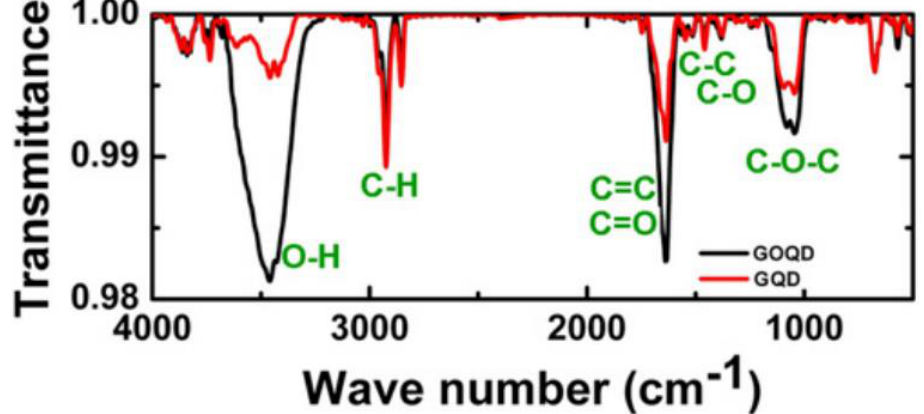
Figure 15. FT-IR spectrum of GQDs (red) and GOQDs (black). Reprinted with permission from Ref. [69]. 2014, IOP Publishing.